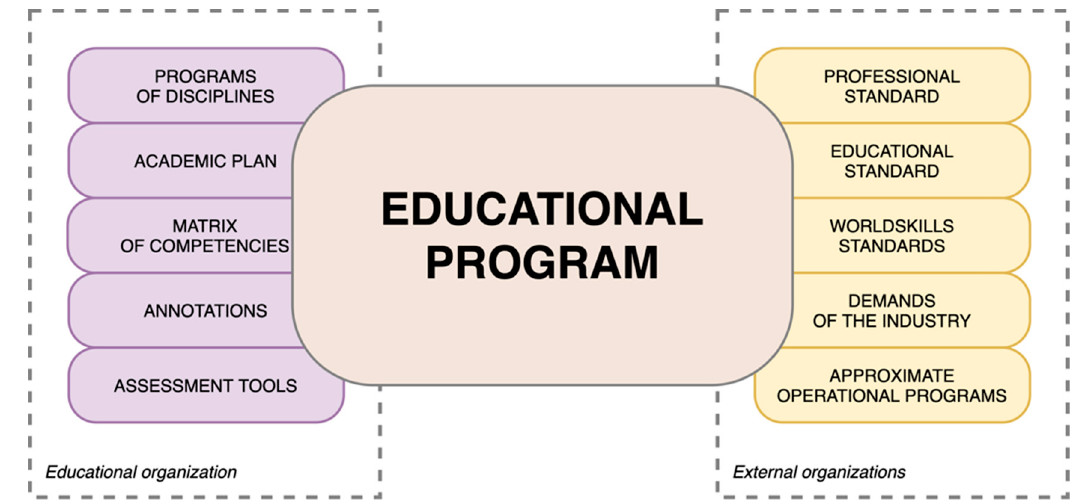
Figure 1. Documents determining the content of an educational program.